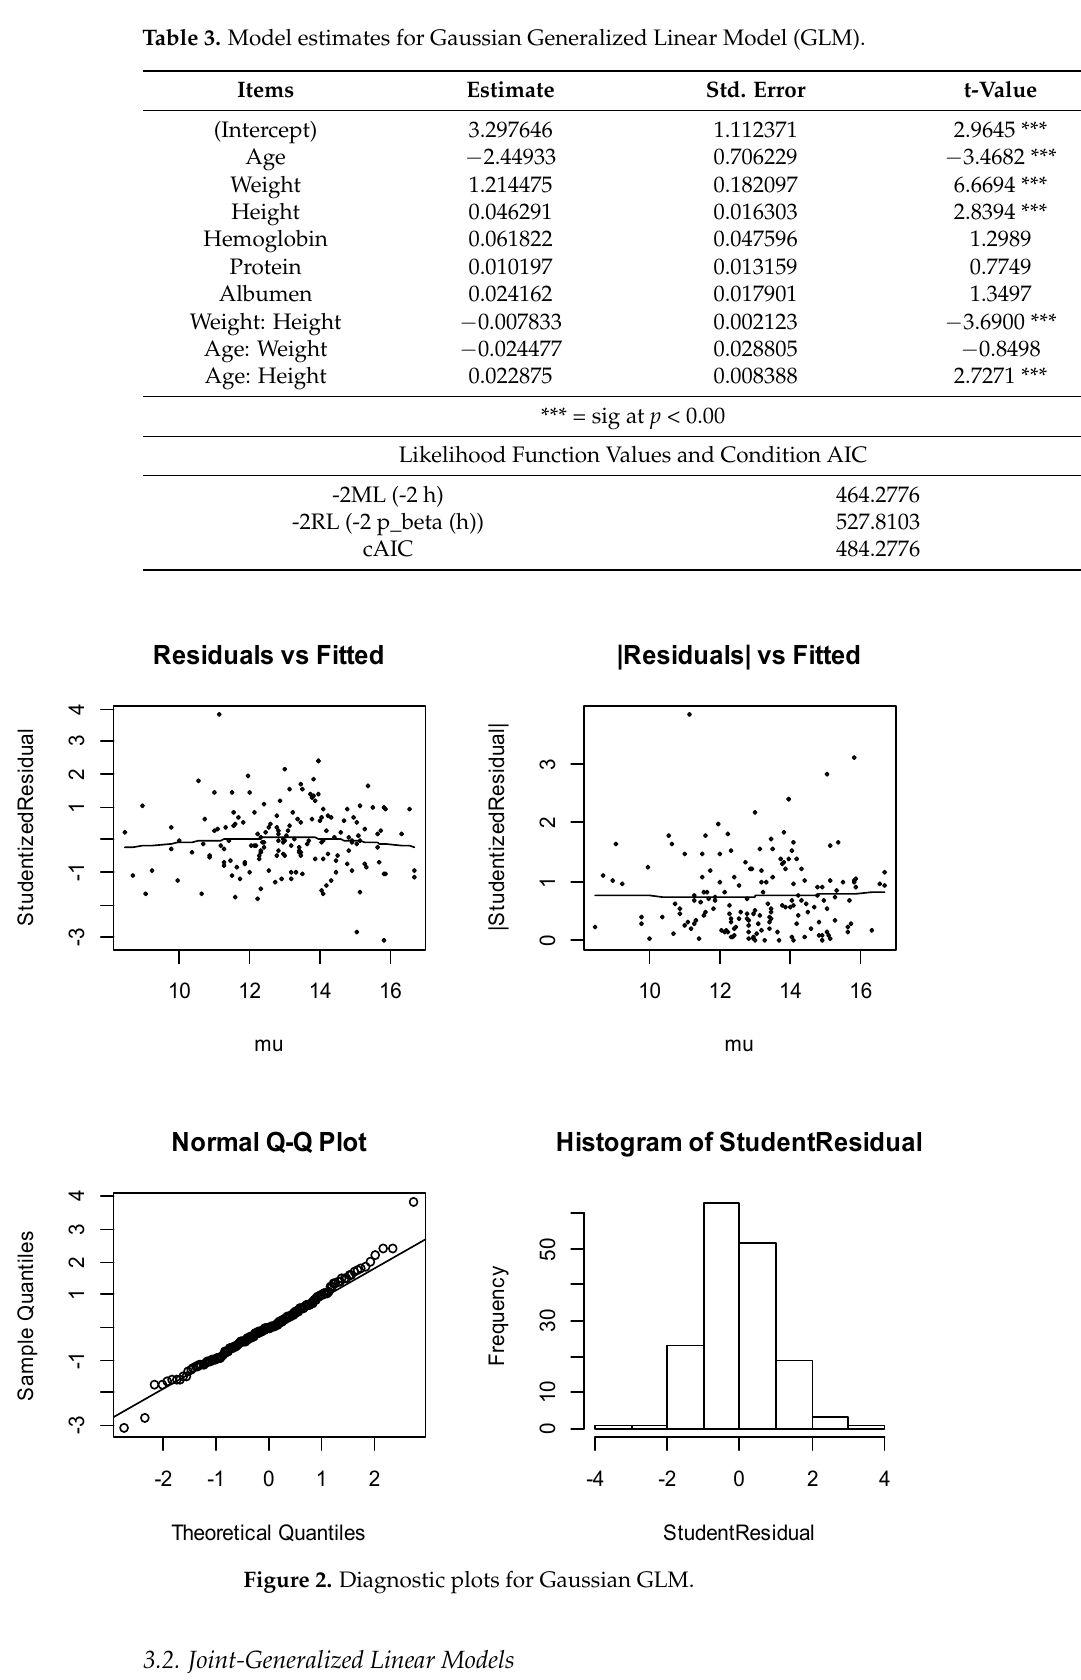
Table 4. Model Estimates for Gaussian Joint-GLM. Items